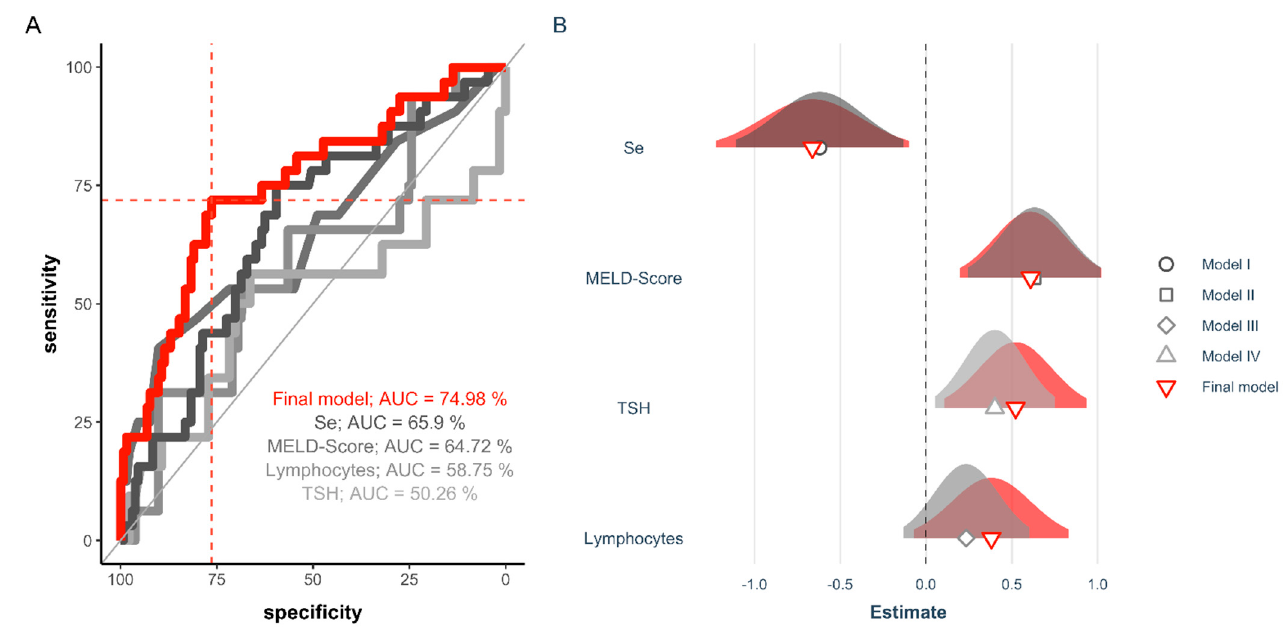
Figure 6. ROC analysis of serum biomarkers to predict non-survival after liver transplantation. The variable selection process included pre-OP TSH, pre-OP neutrophiles, pre-OP lymphocytes, the pre-OP neutrophiles/lymphocytes ratio (NLR), the MELD score, as well as longitudinal data concerning the GPx3 activity, CRP concentration, serum Se and SELENOP data. ( A ) Univariate assessments of total serum Se, the MELD score, pre-OP lymphocytes and pre-OP TSH predict survival of patients undergoing liver transplantation with a similar, albeit only poor to moderate, AUC. The multiple regression model based on the MELD Score, TSH and the lymphocytes at POD 0 together with the Se concentration outperformed any other combination of variables via stepwise AIC selection (final model; AUC = 75%; red line). The corresponding cutpoint according to the Youden Index is indicated in red. ( B ) The estimates of the final model are given alongside with the confidence intervals.